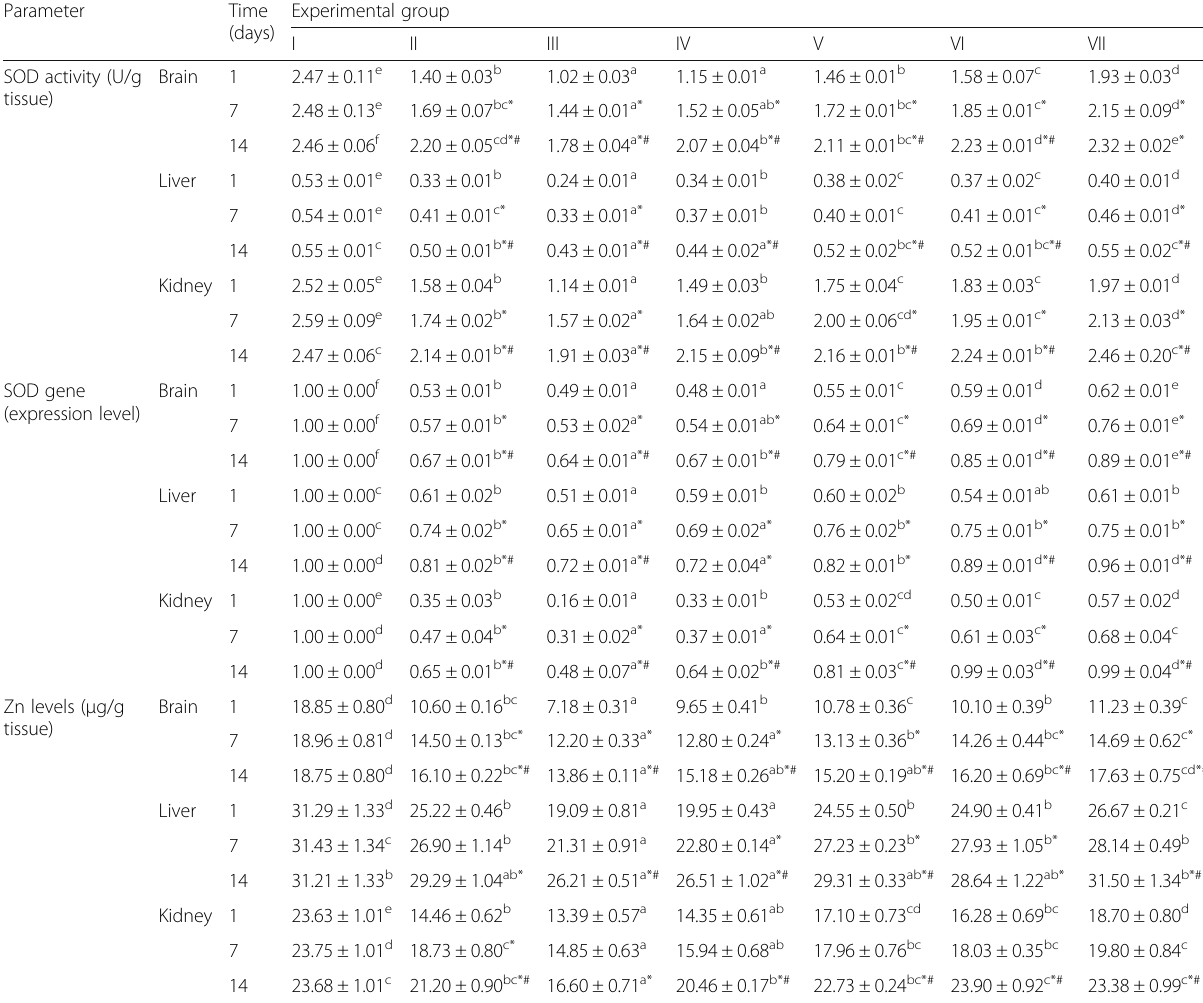
Table 3 The activities of superoxide dismutase (SOD), expression levels of SOD gene, and levels of zinc (Zn), after 1, 7, and 14 days, in the brain, liver, and kidneys of control rats (I), and those administered 0.5 g and 1.0 g of NiO-NPs (II and III), 0.5 g and 1.0 g of Co 3 O 4 -NPs (IV and V) as well as mixtures of NiO-NPs + Co 3 O 4 -NPs (0.25 g + 0.25 g, VI) and (0.5 g + 0.5 g, VII) per kg body weight, respectively